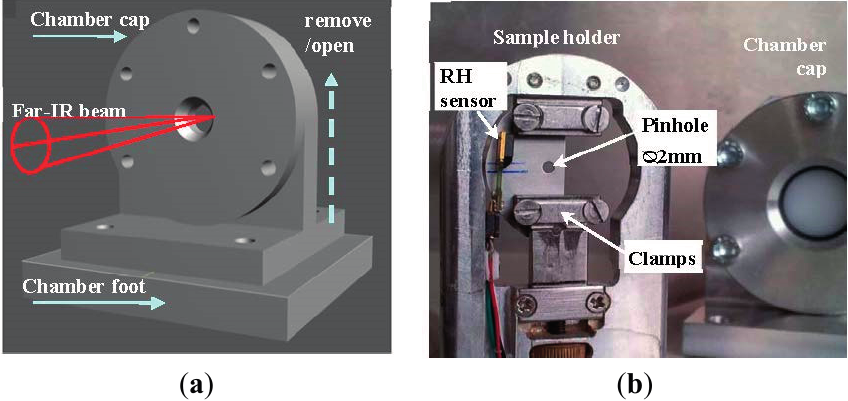
Figure 1. Sample chamber for far-IR measurements of biological samples in controlled environmental conditions. ( a ) Schematic drawing of the sample chamber with the chamber cap fixed on the chamber foot. The humid air is introduced into the chamber from outside though drilled pipes in the chamber foot; ( b ) The sample holder (on the left) and the removable chamber cap (in the back right side) are shown. The sample fixed with clamps can be stretched using a micrometer screw. Behind the sample a pinhole is positioned to narrow the beam spot and, thereby, significantly improving the spectral quality. A digital humidity and temperature sensor (RH sensor) is positioned close to the sample.